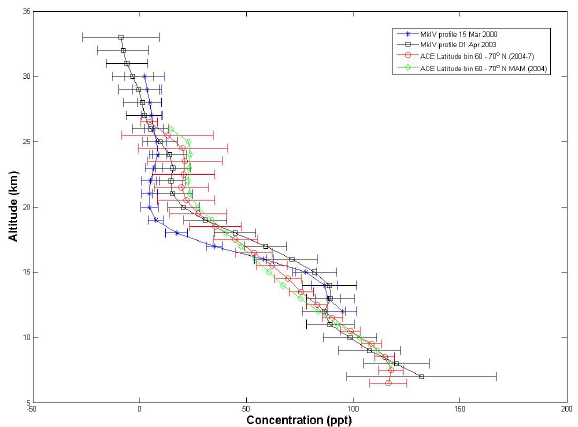
Fig. 7. The average carbon tetrachloride volume mixing ratio pro- file for the latitude bin covering 60–70 ◦ N (red line with circles) from the ACE mission between February 2004 and August 2007 is displayed. The average seasonal profile for MAM (March-April- May) over the 60–70 ◦ N latitude bin (green line with diamonds) is included solely for 2004. These average profiles are compared with two balloon profiles from near Esrange, Sweden (62–70 ◦ N), obtained by Toon et al. (unpublished data) using the MkIV FTS in- strument on the 15 March 2000 (blue line with asterisks) and 1 April 2003 (black line with